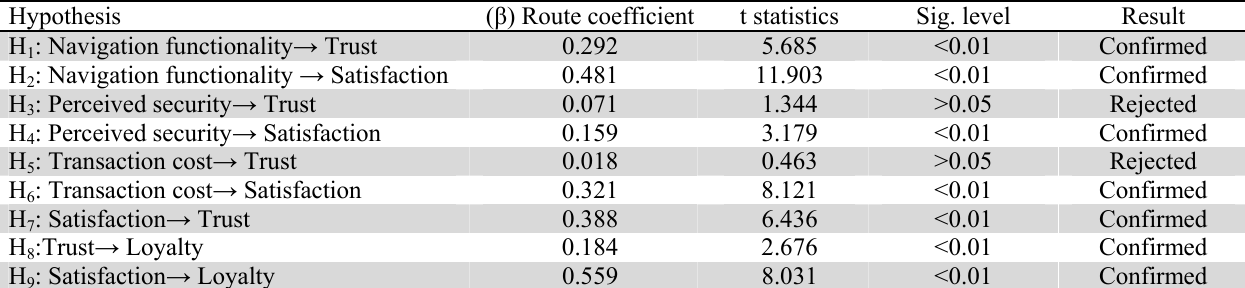
Route coefficients and hypotheses tests results